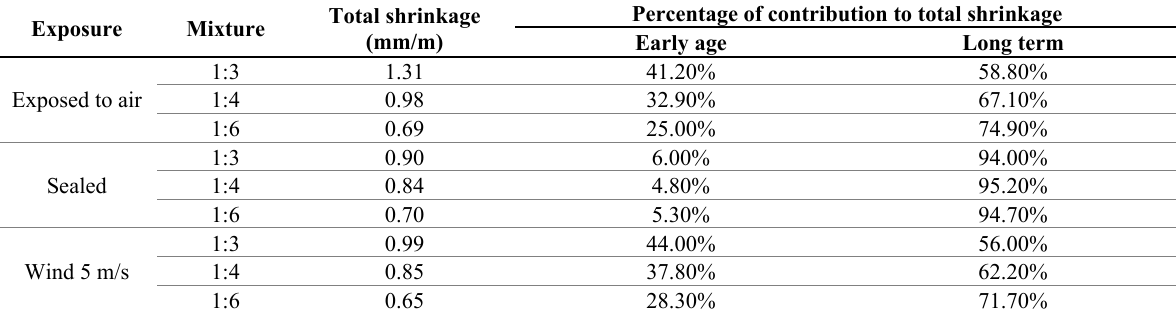
Table 6. Comparison between initial and long-term shrinkage and their contributions to total